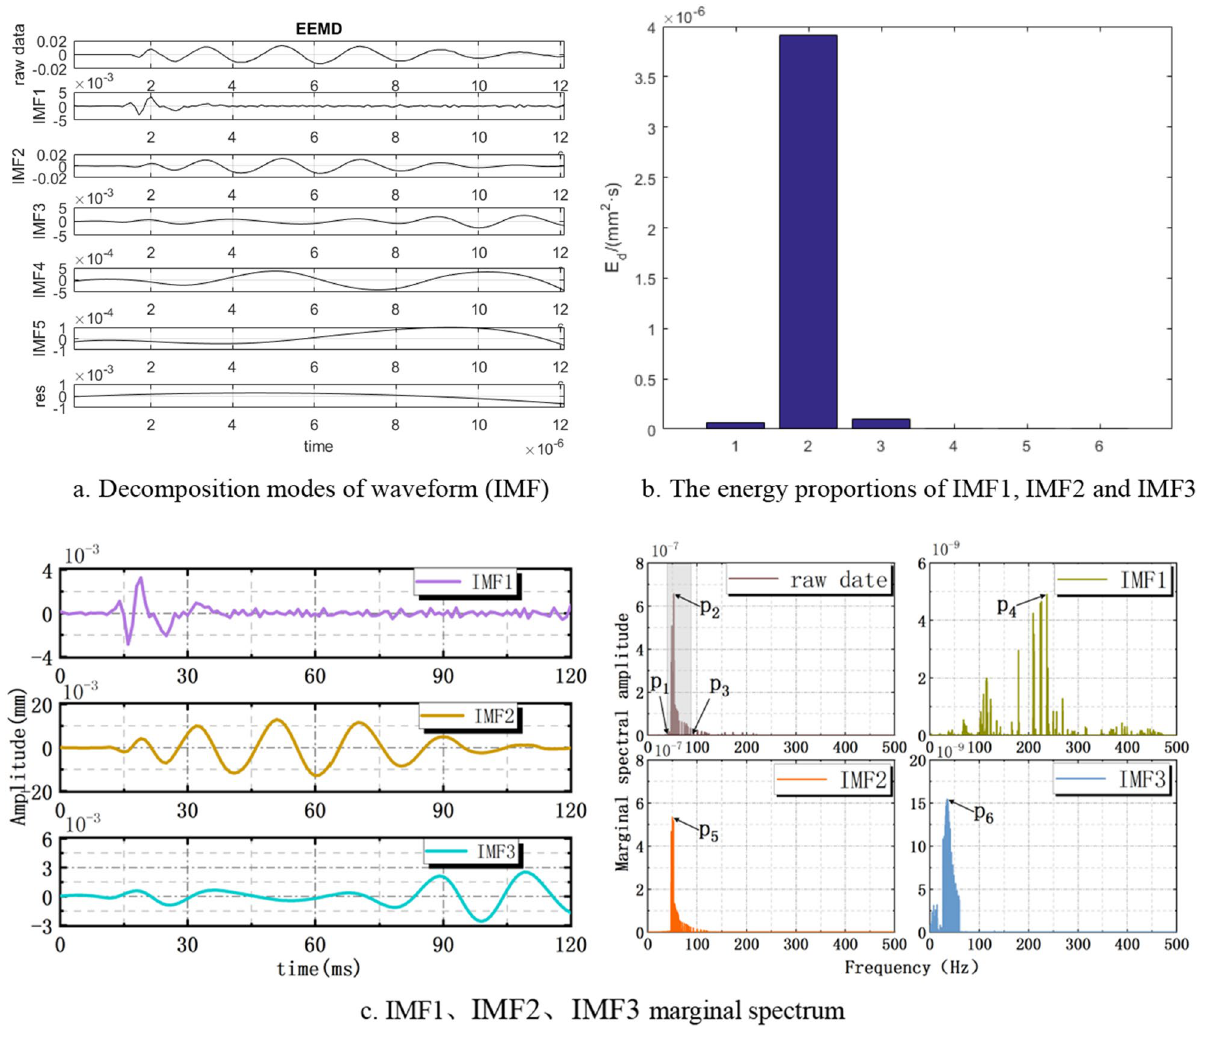
Figure 8. The waveform decomposition under 2# action point which are symmetrical along the short central axis. It’s found that the stress σ x of the 1st and 6th effective mode are greater than the stress σ y , the stress σ y of the 5th effective mode is greater than the stress σ x , the shear stress is relatively small. So that the tensile failure is the main failure pattern in the center of thin plate rock mass. At the middle of the four sides on the thin plate rock mass, the stress σ x , σ y and τ max concentrate together. The shear stress τ and shear stress, four corners are the shear failure caused by the shear stress. On the area outside the four sides and four corners, τ load, many main cracks are formed along the long central axis, a small number of secondary cracks are formed along the short central axis of thin plate. Numerical simulation of the dynamic damage and failure. In LS-DYNA, the PLASTIC_KINEMATIC mate- rial model and Cowper Symonds model are used to simulate the failure of the thin plate rock mass under the dynamic load 67 . The dynamic damage and failure process of thin plate rock mass as shown in Fig. 10. From Fig. 10a, it’s found that cracks first appear in the middle and corners of the four sides on the thin plate, these cracks develop further along the boundary. Subsequently, cracks are generated in the center of the thin plate, the cracks extend outward along the long and short central axes of the thin plate in Fig. 10b. And the number of cracks along the long central axis is much larger than the cracks along the short central axis in Fig. 10c. The numerical simulation results are consistent with theoretical derivation in Fig. 9. So that, the failure position can be determined by 1st effective mode which in the middle of the four sides, four corners and central area of the thin plate. The trend of the cracks can be determined by the 5th and 6th effective modes, which along the long central axis and short central axis.